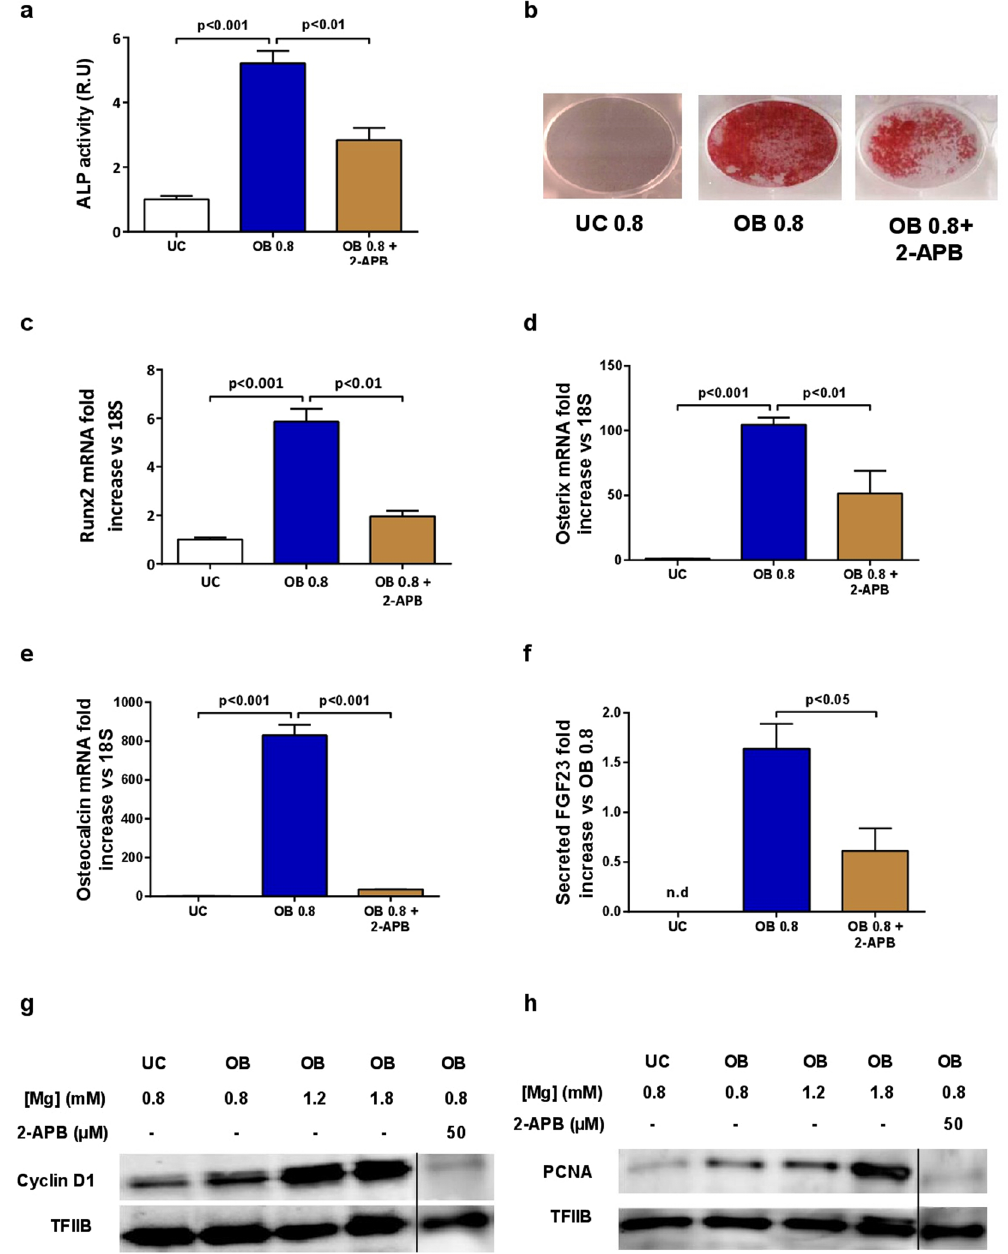
Figure 2. Decrease in intracellular Mg 2 + reduces osteogenesis, mineralization and proliferation during differentiation of rat MSC into osteoblasts. Inhibition of Mg 2 + entry by blocking TRPM7 with 2-APB (50 µ M) significantly decreased ( a ) ALP activity and ( b ) matrix mineralization as assessed by Alizarin Red S staining. Specific osteogenic marker genes ( c ) RUNX2 , ( d ) OSTERIX and ( e ) OSTEOCALCIN were down-regulated by inhibition of Mg 2 + entry with 2-APB. ( f ) FGF23 production was decreased by inhibition of the Mg 2 + transporter TRPM7 with 2-APB. ( g ) Western blots show an increased stimulation of Cyclin D1 and ( h ) PCNA according to Mg 2 + concentrations at 21 days of osteogenic differentiation. TFIIB was used as a loading control, UC - undifferentiated cells, OB - osteoblasts. Bars show mean ± SEM. n = 4. Vertical black line separates results from different gels using the same exposure and protein load (see Supplementary Figures